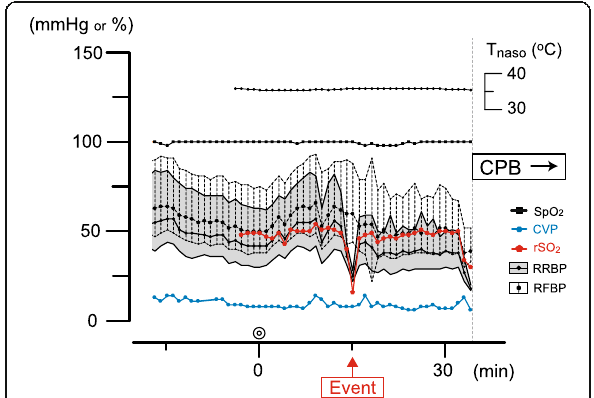
Fig. 1 Changes in parameters monitored during general anesthesia around the event of rSO 2 depression. The graph represents changes of each parameters monitored every minute during general anesthesia from the beginning of the operation to the period just before initiation of cardiopulmonary bypass (CPB). The parameters are as follows: right radial blood pressure (RRBP), right femoral blood pressure (RFBP) and central venous pressure (CVP), oxygen saturation of peripheral artery (SpO 2 ), values of regional cerebral oxygen saturation (rSO 2 ) measured with INVOS 5100C, and nasopharyngeal temperature (T naso ). Some of these points beyond measurement limits are considered noise and were thus